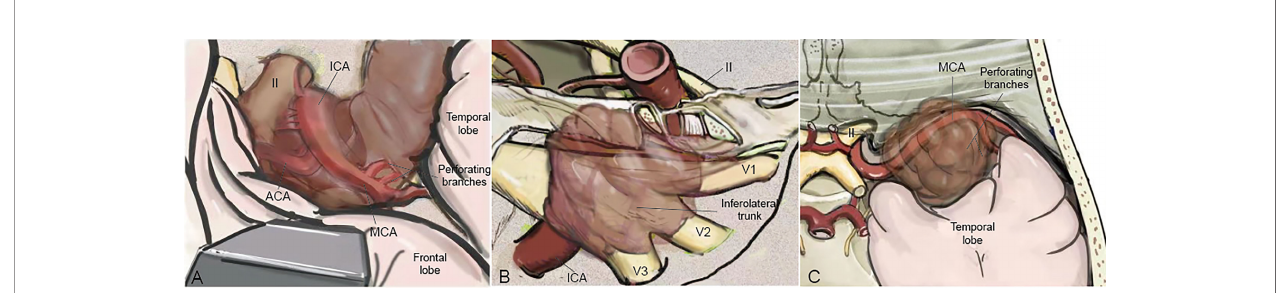
FIGURE 5 | The cranial artery, perforating branches, and the cranial nerve are involved in the PCMs. The ACA, ICA, MCA, and their perforating branches were involved in ACMs (A) while MCA and its perforating branches were the most involved in MSWMs (C) . The inferolateral trunk and the meningohypophyseal trunk of the ICA were encased by CSMs